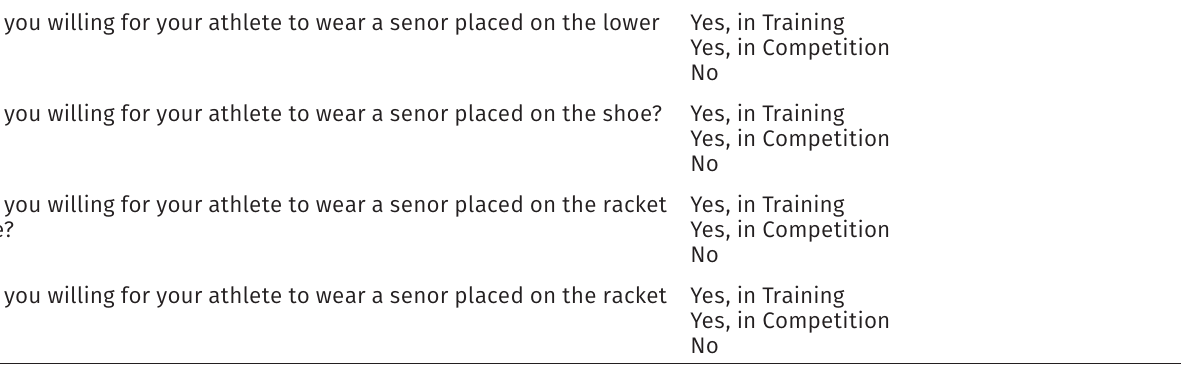
Yes, in Training Yes, in Competition No Yes, in Competition No